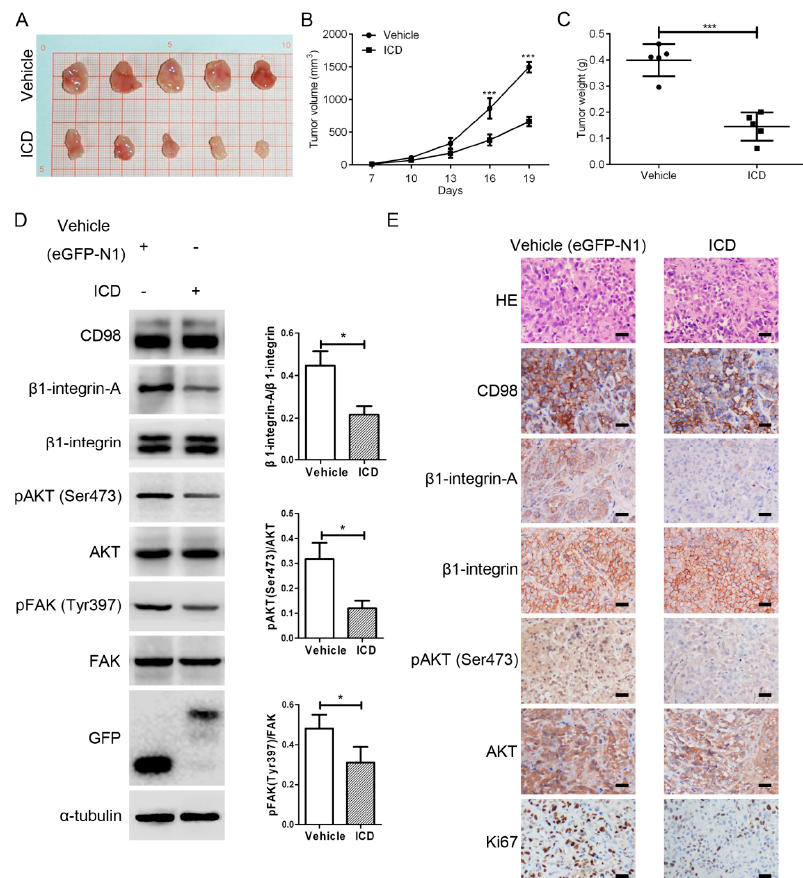
Figure 2. CD98-ICD inhibits tumorigenicity of SMMC-7721 cells in vivo. ( A , C ) Primary tumors were harvested and weighed (each group had five animals, and experiments were repeated twice, each round or square dot represent one tumor). The data are expressed as mean ± SD; *** p < 0.001; ( B ) tumor volumes were determined at various time points; *** p < 0.001; ( D ) expression levels of β 1-integrin-A, p-Akt and p-FAK were analyzed by Western blot. Western blot scanning densitometry is shown on the right for three independent experiments on the right. Blots were probed for β 1-integrin, AKT, or FAK independently to ensure equal protein loading; * p < 0.05; ( E ) expression levels of β 1-integrin-A, p-Akt and p-FAK analyzed by immunohistochemistry. Scale bar, 100 µ